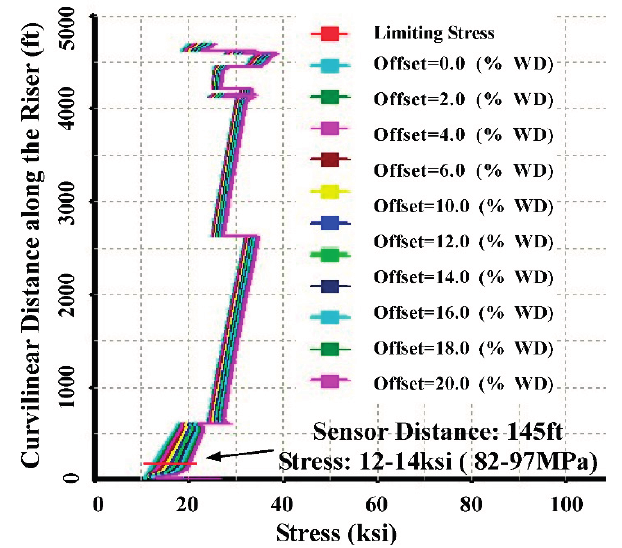
Figure 6. CNOOC mechanical simulation stress